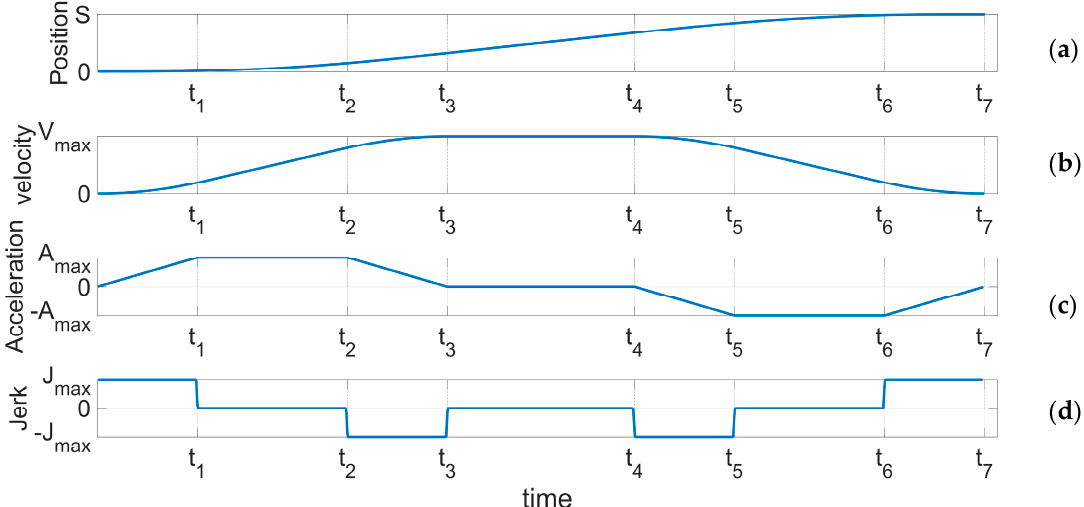
Figure 7. ( a ) Displacement of the seven-segment S curve over time. ( b ) Velocity of the seven-segment S curve over time. ( c ) Acceleration of the seven-segment S curve over time. ( d ) Jerk of seven-segment S curve over time.